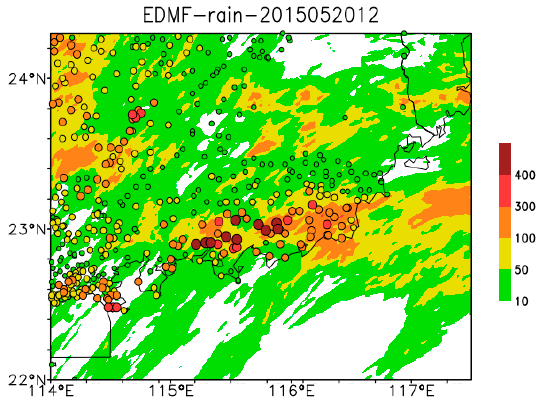
Figure 6. The 24-h accumulated rainfall from the D4 simulation for 1200 UTC 19 May–1200 UTC 20 May 2015, using the TEMF scheme. The shading represents the simulation results, the dots denote the observations, and the magnitudes of the simulation and the observation share the same color bar.